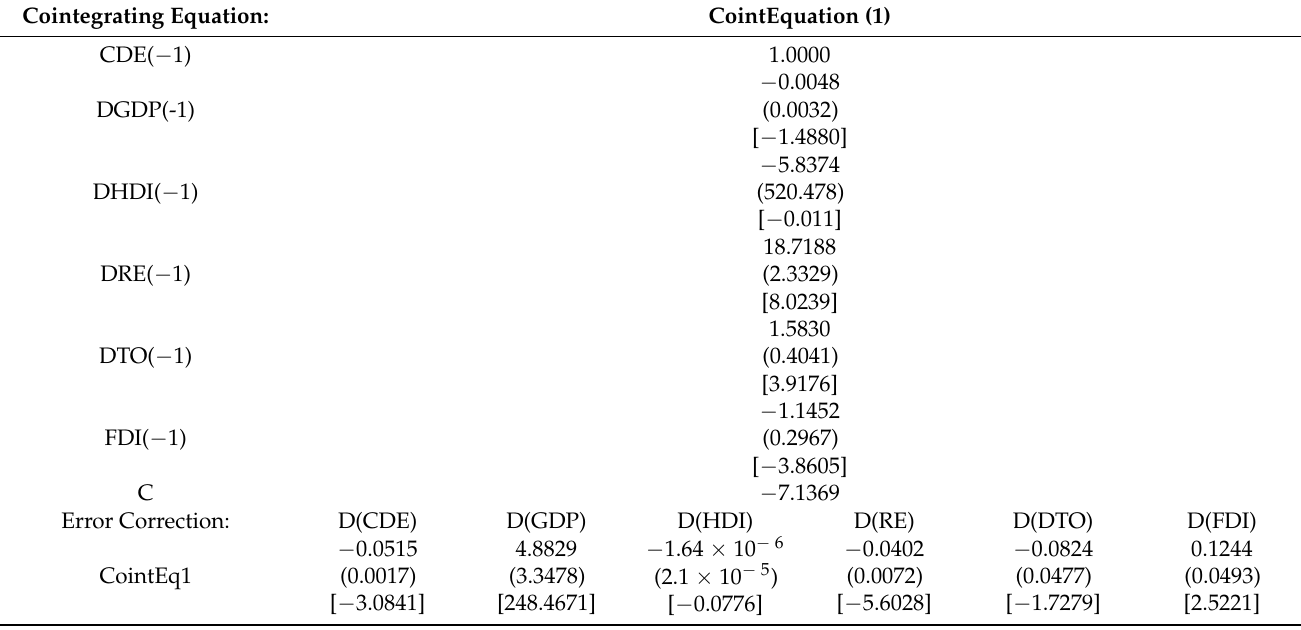
Table 7. The Long-Run and Short-Run